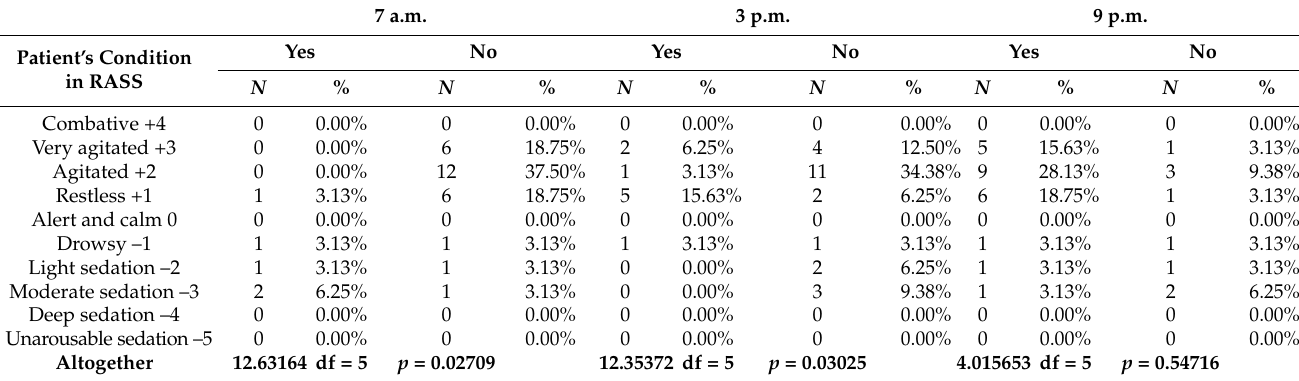
Table 4. Characteristics of patient states on the Richmond Agitation Sedation Scale (RASS) during direct coercion. 7